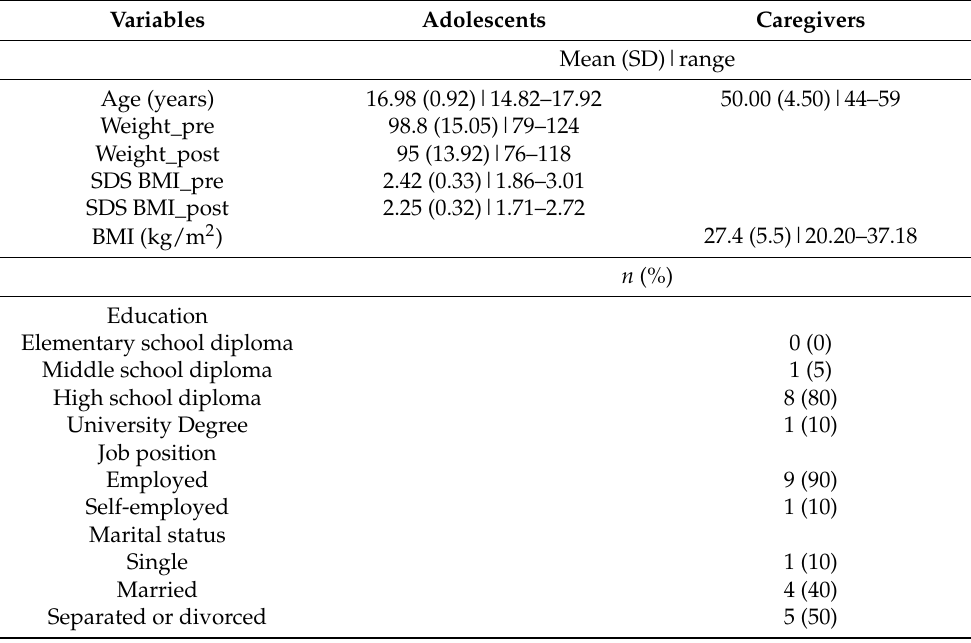
Table 1. Demographic and clinical characteristics of the